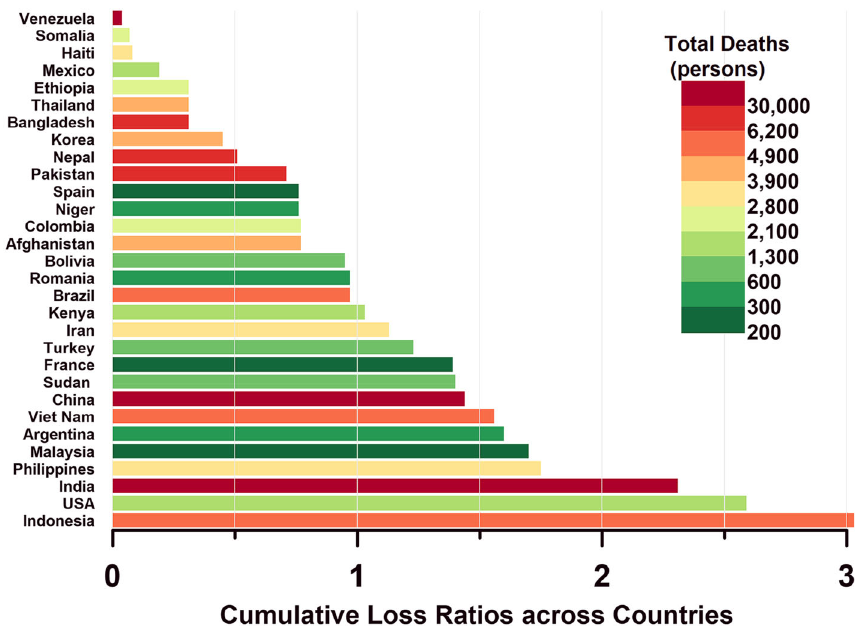
Fig. 3 Cumulative loss ratios of flood-induced deaths across countries in the four decades (1976 to 2016) based on the EM-DAT data. Colors and lengths of bars represent the total deaths and cumulative loss ratios due to floods,